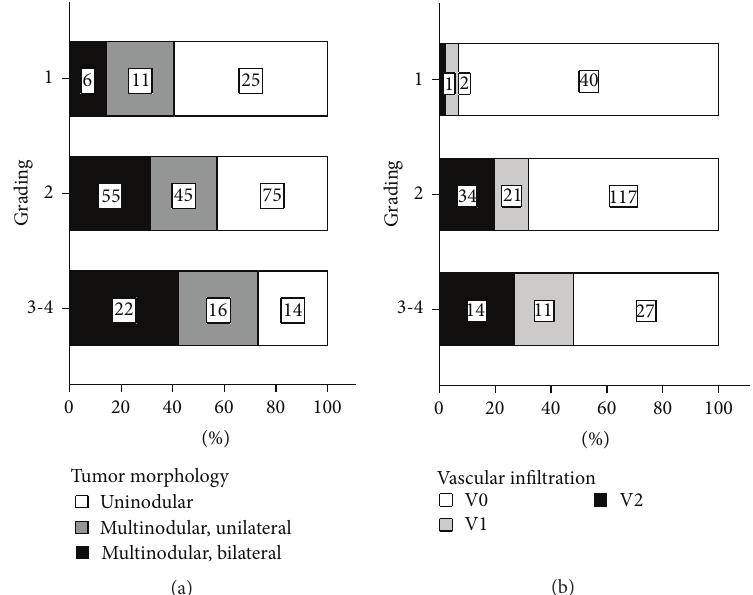
Figure 10: (a) Proportion of vascular infiltration with respect to tumor grading (G). The incidence of vascular infiltration and the proportion of small (V1) and large (V2) infiltrated vessels increased with each step of tumor dedifferentiation (G 1 → G 2 → G 3 - 4 ) ( 𝜒 2 𝑝 = 0.006 ). The overall incidence of vascular infiltration was 7%, 31%, and 48% for G1, G2, and G3-4 graded tumors, respectively. The proportion of small vascular infiltration (V1) was 5%, 12%, and 21% for G1, G2, and G3-4 graded tumors, respectively. The proportion of large vessel infiltration (V2) was 2%, 20%, and 27% for G1, G2, and G3-4 graded tumors, respectively. (b) Proportions of uninodular/multinodular tumors with unilateral/bilateral hepatic spreading in G1–4 graded tumors. There was a close correlation between tumor grading and intrahepatic tumor spreading. The proportion of multinodular and bilateral spread tumors increased with each step of tumor dedifferentiation (G 1 → G 2 → G 3 - 4 ) ( 𝜒 2 𝑝 = 0.016 ). The proportion of uninodular tumors was 59%, 43%, and 27% for G1, G2, and G3-4 graded tumors, respectively. The proportion of multinodular/unilateral tumors was 26%, 26%, and 31% for G1, G2, and G3-4 graded tumors, respectively. The proportion of multinodular/bilateral tumors was 14%, 31%, and 42% for G1, G2, and G3-4 graded tumors,